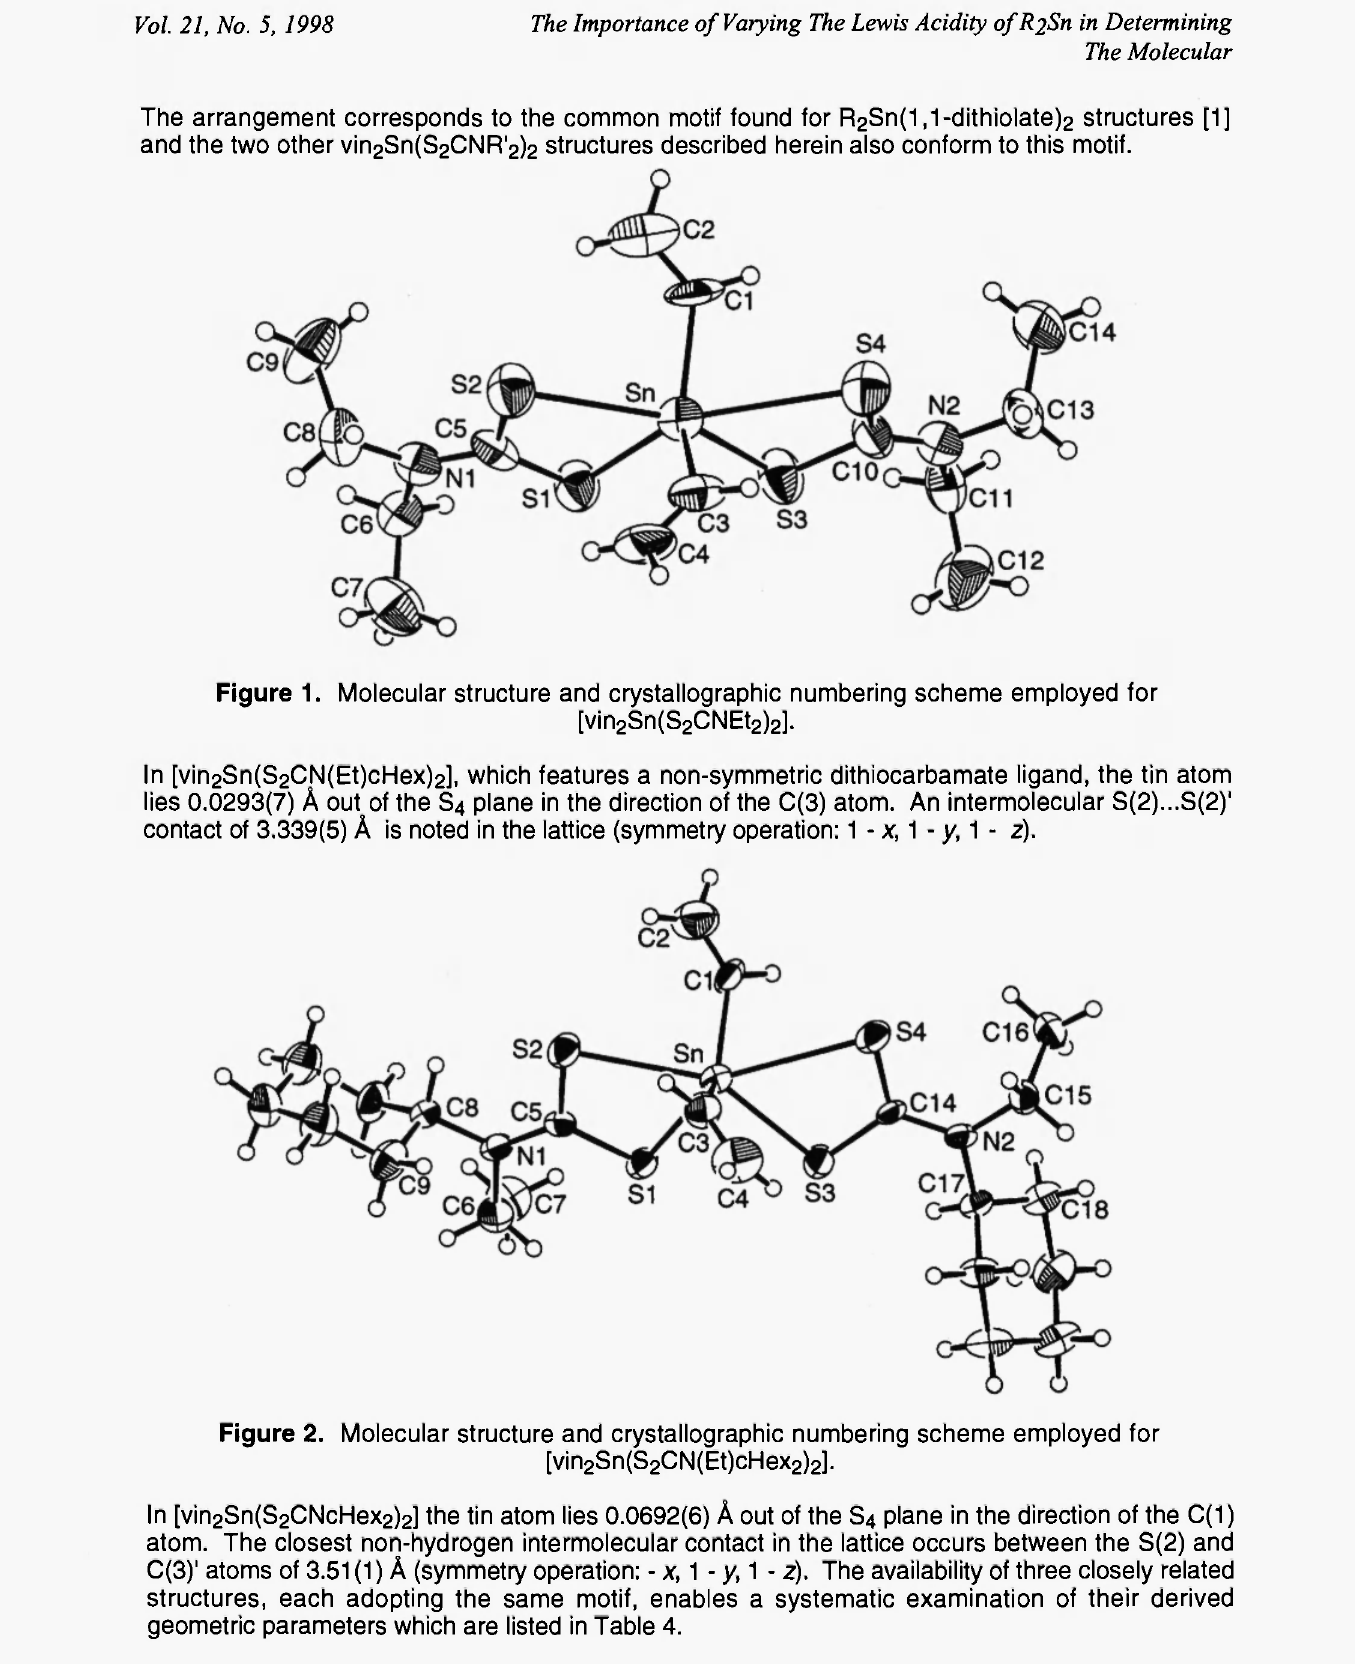
Figure 2. Molecular structure and crystallographic numbering scheme employed